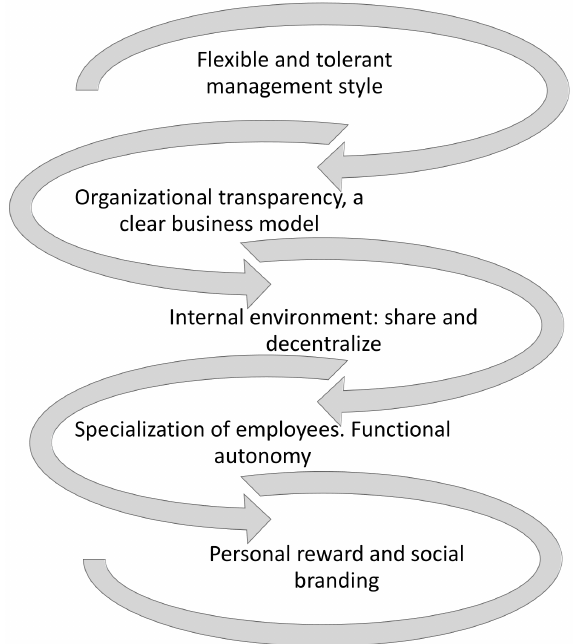
Fig. 4. A process of Innovative response in CAS